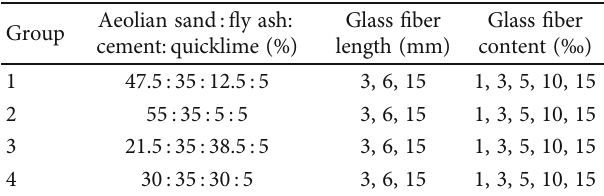
Figure 1: The photograph of glass fi ber. Table 1: Experimental scheme design [17].